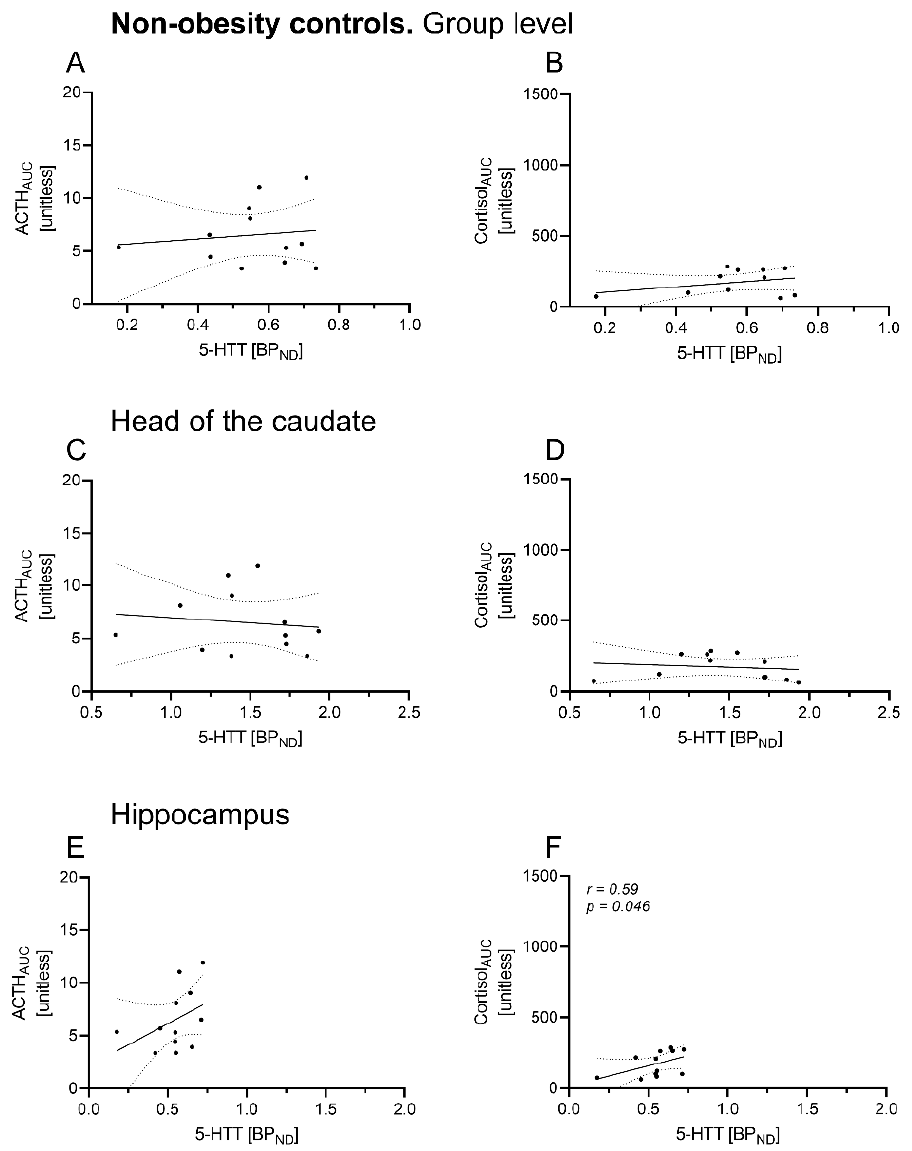
Figure 3. Association of 5-HTT BP ND with HPA axis responsiveness in dedicated brain areas in participants without obesity. Spearman correlation of 5-HTT BP ND of dedicated brain areas with hypothalamic–pituitary–adrenal (HPA) axis responsiveness in non-obesity controls. ACTH and cortisol AUC were derived from the dex/CRH test (unitless). Significant positive association was found for 5-HTT BP ND with cortisol AUC in the hippocampus ( F ), while the other associations did not reach significance ( A – E ). Dots indicate individual 5-HTT BP ND and HPA axis hormone values of the participants. Data are given with regression line and 95% confidence interval. dex, dexamethasone; CRH, corticotropin-releasing hormone; ACTH, adrenocorticotropic hormone, AUC, area under the